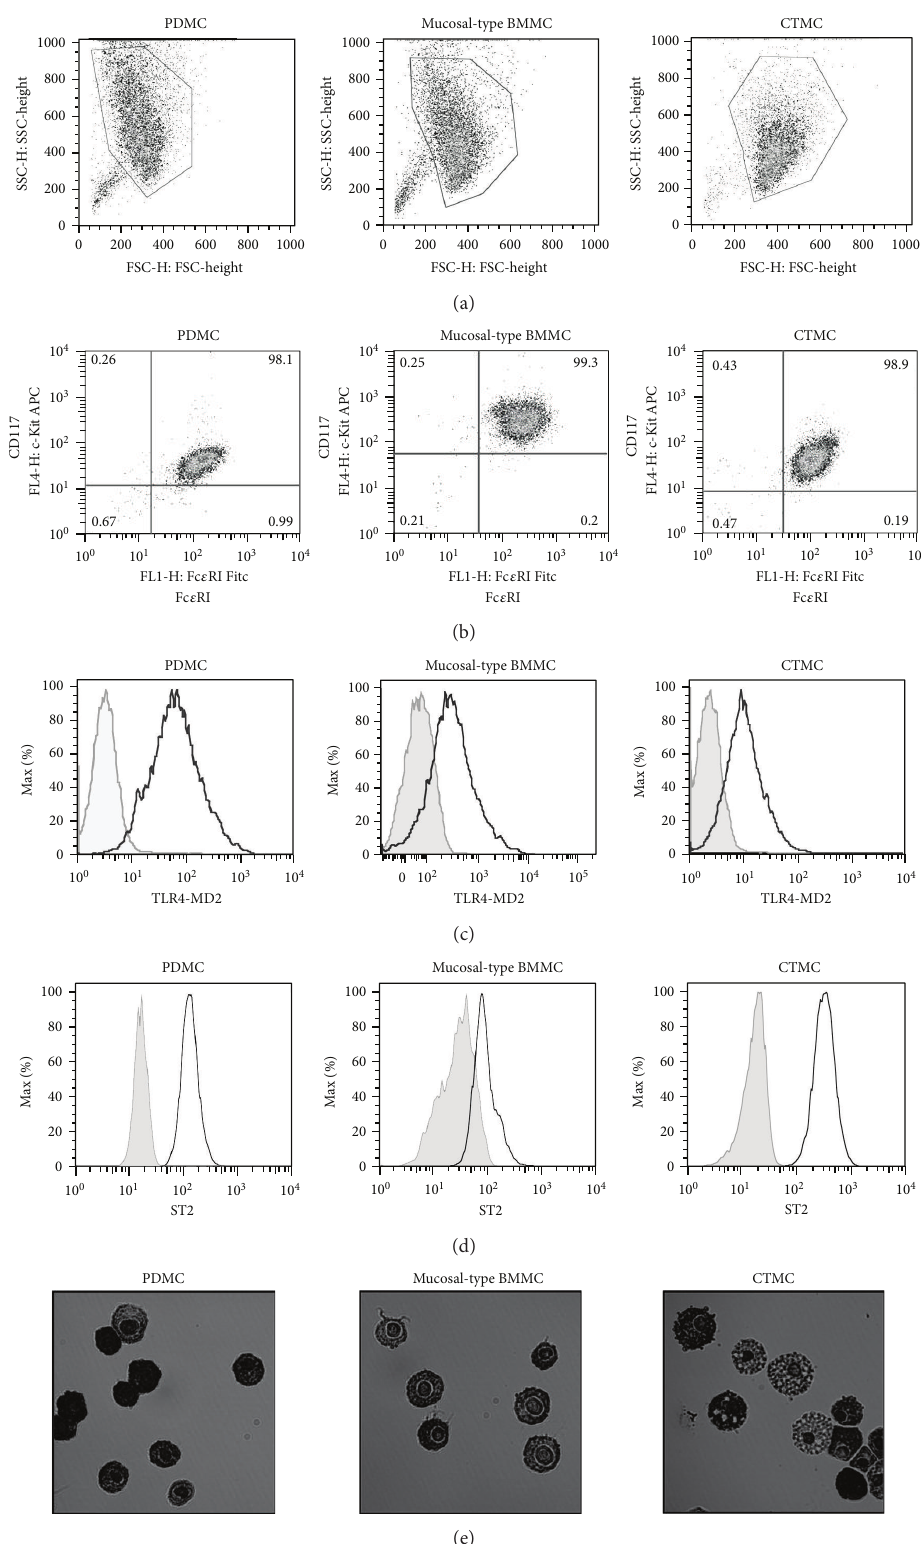
Figure 1: Phenotyping of mast cell subsets. Exemplar plots of mast cell phenotyping by flow cytometric analysis are shown in (a)–(d). FSC and SSC parameters of PDMC, mucosal-type BMMC, and CTMC cultured in vitro for 28 days (a) and gating (relative to isotype controls; not shown) of the consequent CD117 + Fc 𝜀 R1 + cell population ( > 98%; (b)) prior to the analysis of their TLR4 + expression (c) are shown. In parallel experiments, ST2 expression of CD117 + Fc 𝜀 R1 + cells in the various populations was determined (d). Gray shaded plots (c-d) are isotype controls. In (e), exemplar images of toluidine blue staining of the mast cell populations (x10) are shown. The data are representative of at least 2 independent